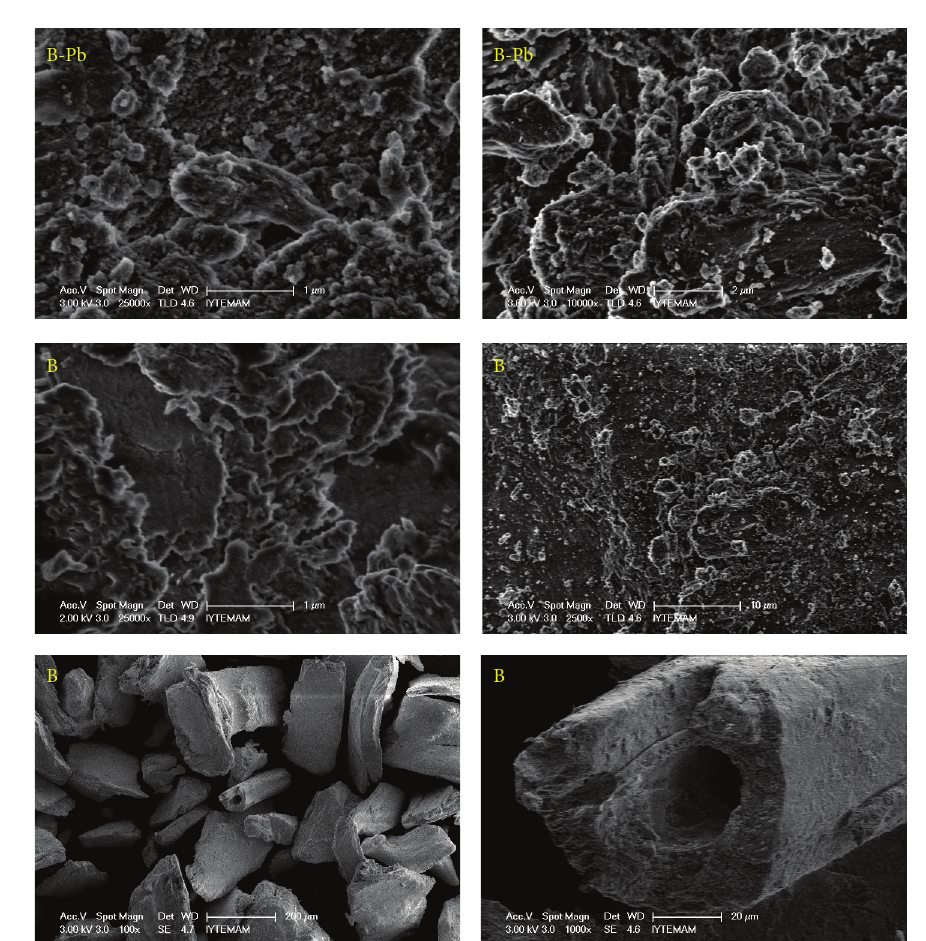
Figure 4: SEM images (1-2 𝜇 m) of (a) B-Pb and